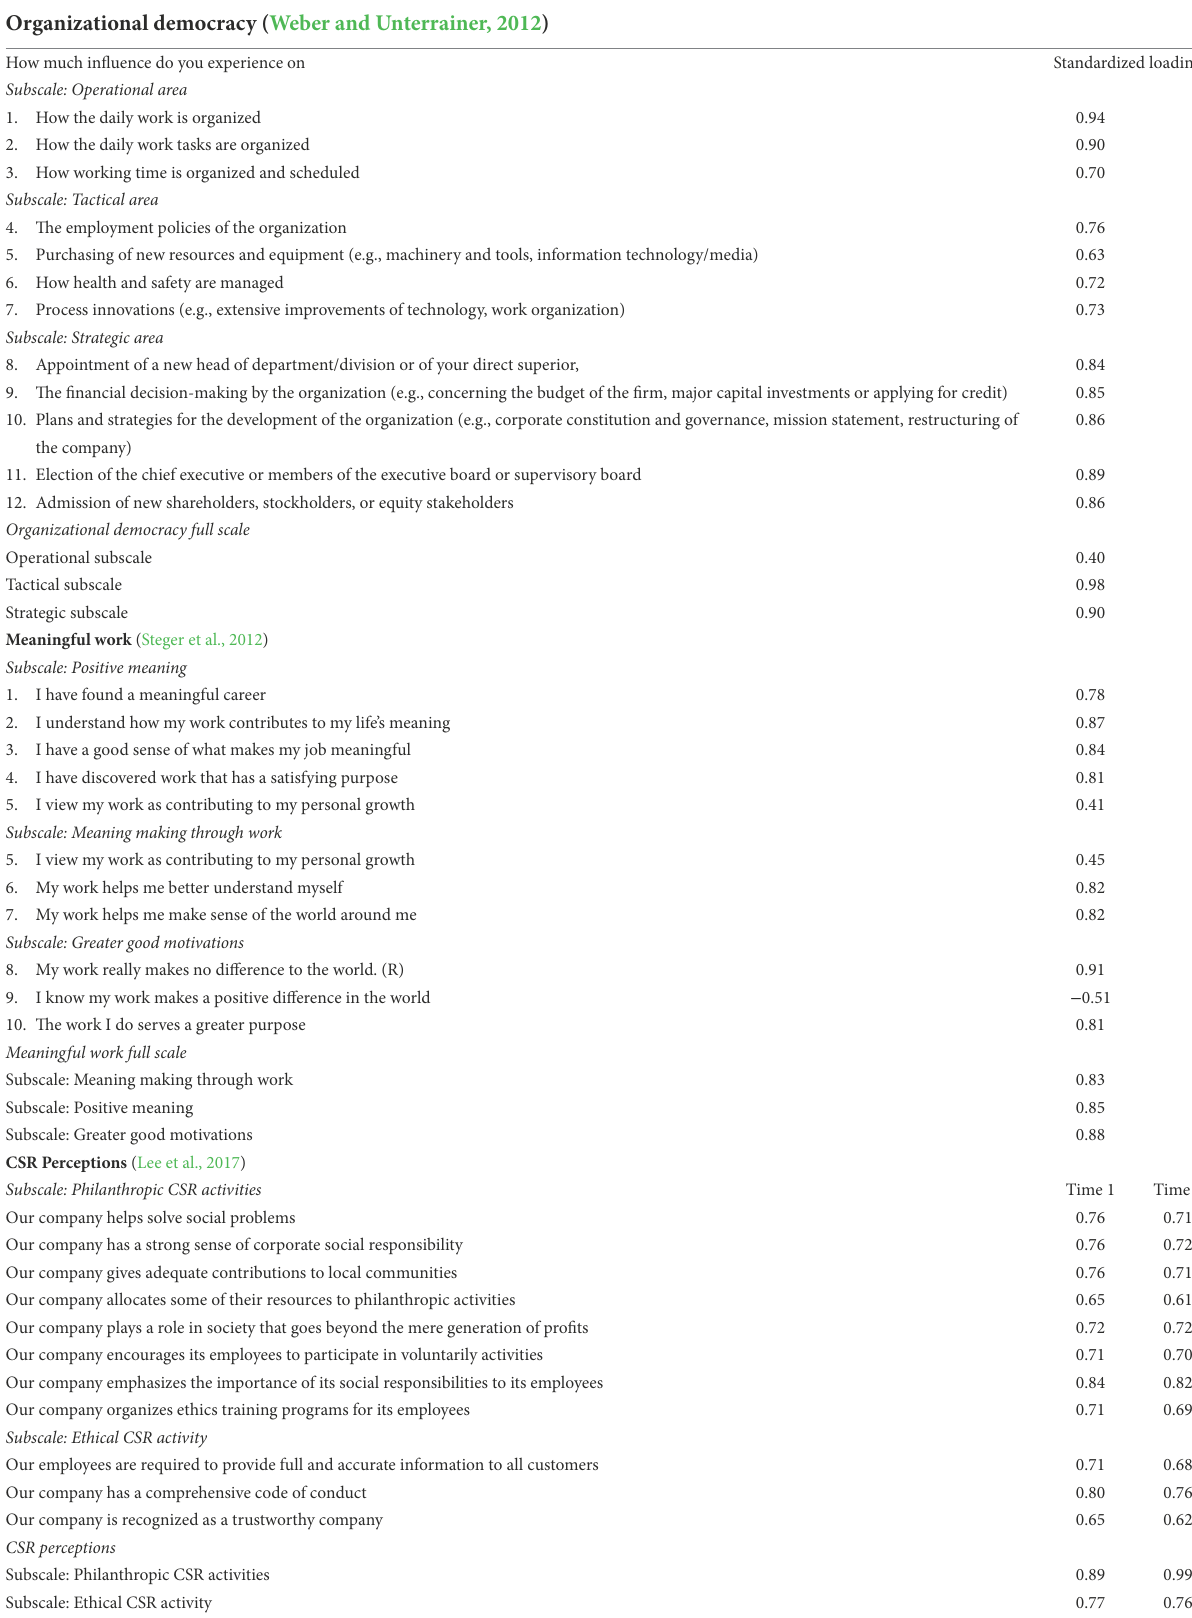
TABLE 2 Items, subscales and standardized